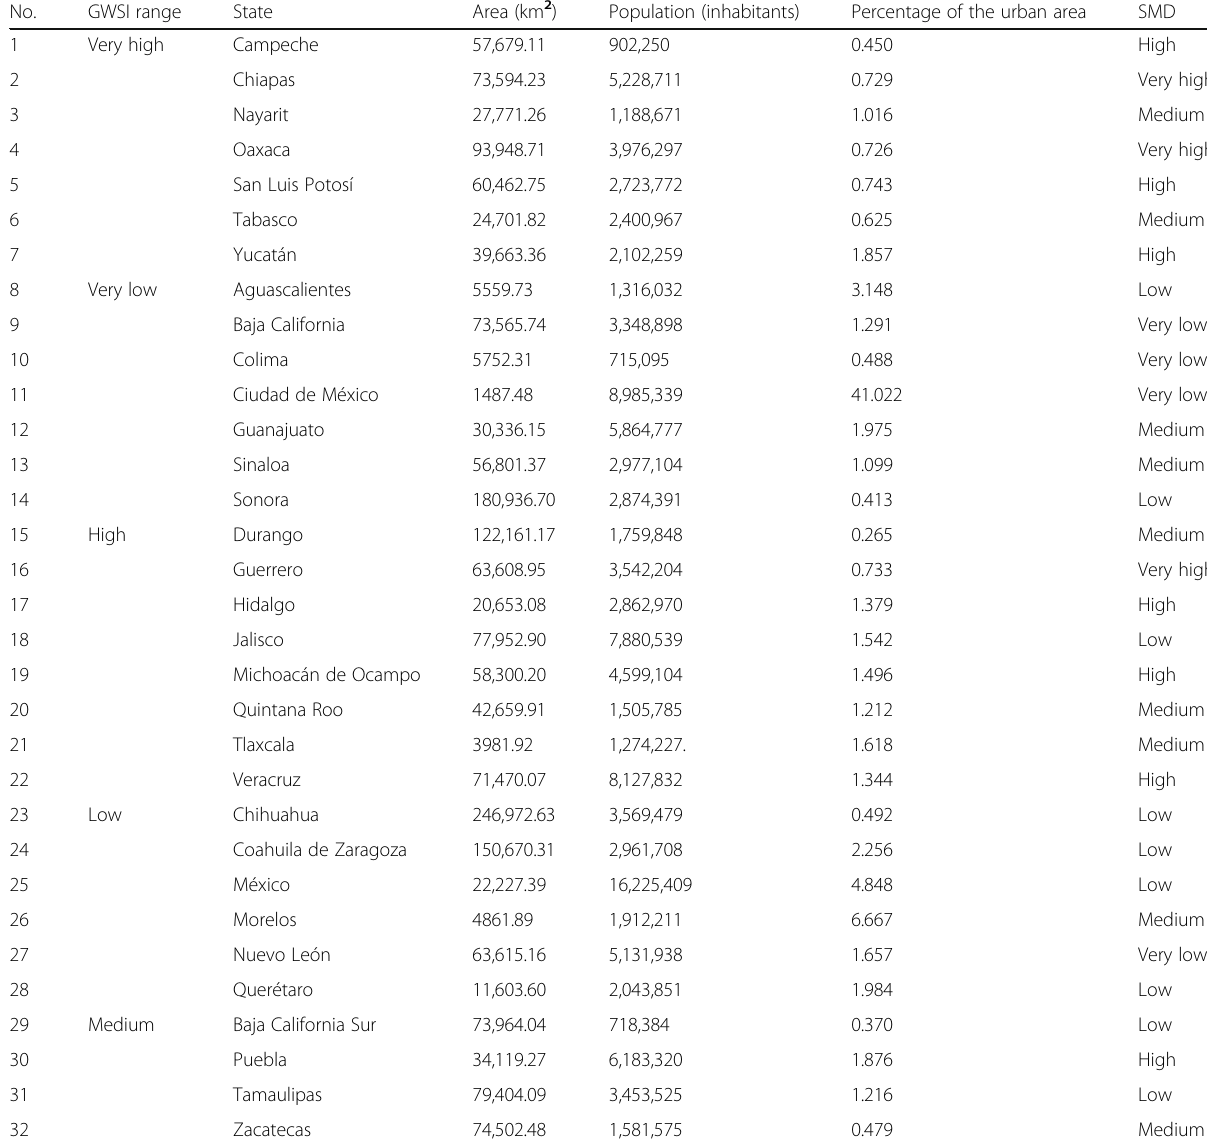
Table 5 Indicators per Mexican